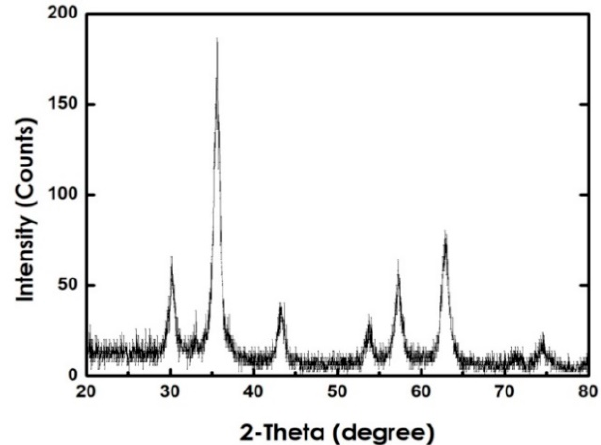
Figure 11. XRD pattern for the prepared nanoparticles.